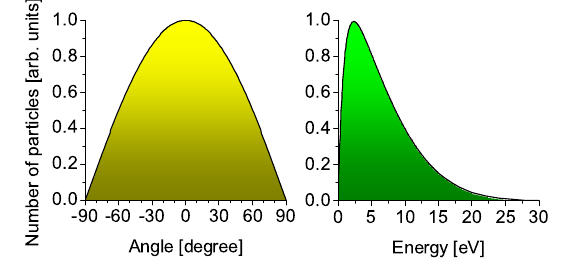
FIG. 4. Angular (left) and energy distribution (right) of simu- lated secondary electrons.